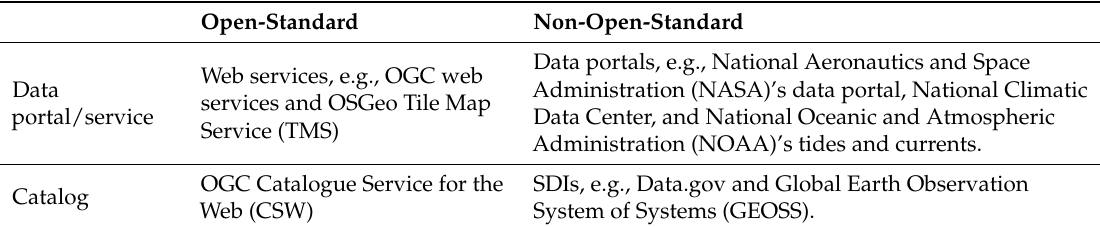
Table 1. Categories of existing GeoWeb resource discovery approaches.